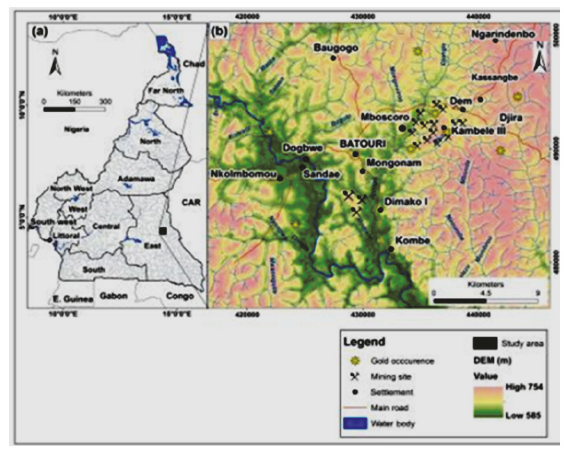
Figure 1: Location of the study site and major rivers.